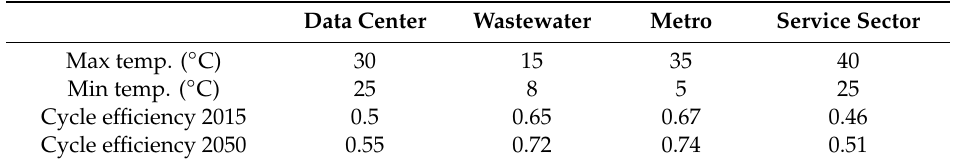
Table 2. Assumptions used to estimate the temporal profiles of the four unconventional excess heat (UEH)